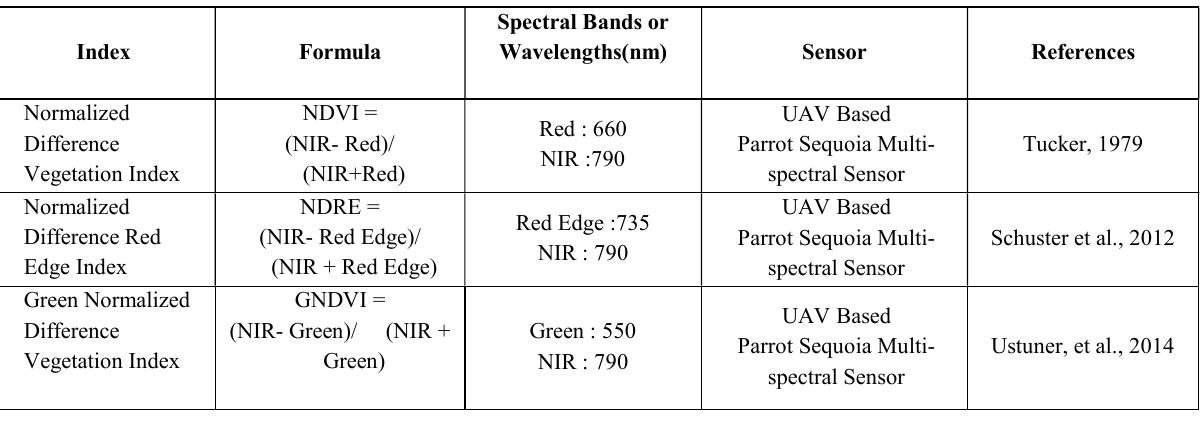
Table 2. Details of vegetation indices used in the